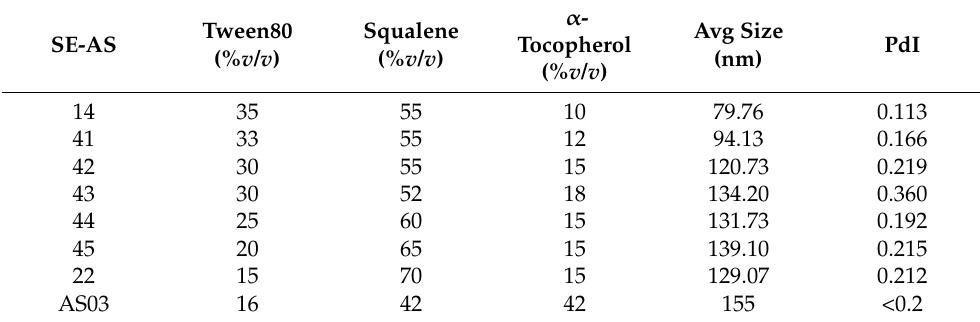
Table 1. % v / v in oil: surfactant mixture for novel SE-AS combinations and size (nm) and PdI using DLS. SE-AS 22 is shown for